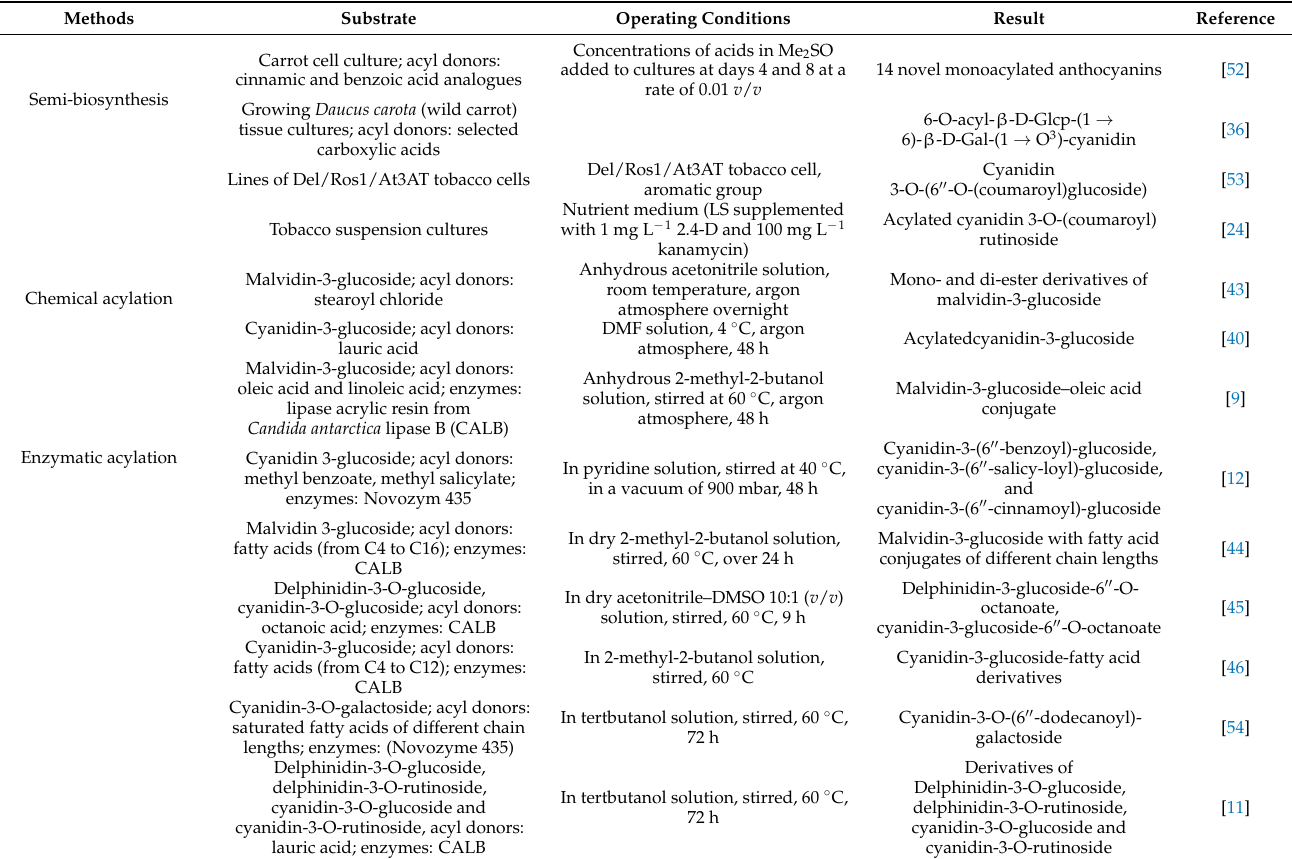
Table 1. Studies on the synthesis of acylated